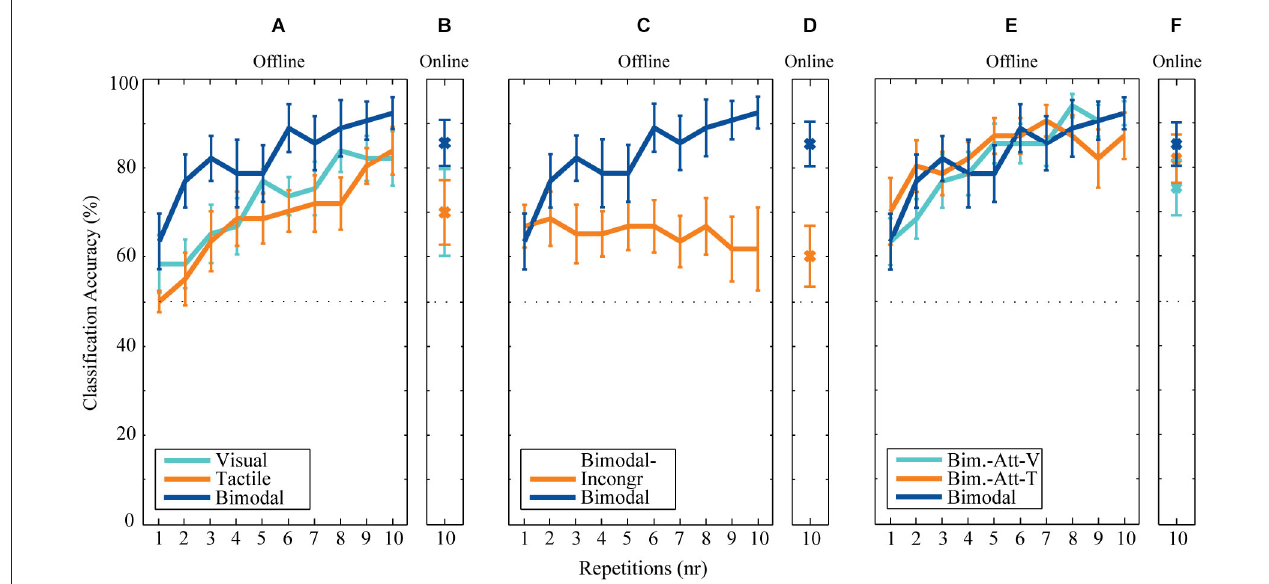
repetition for the conditions involved in the analysis of the second research question (the effect of Location Congruency). (E) Offline and (F) online classification accuracies after each repetition for the conditions involved in the analysis of the third research question (the effect of Attending Modality).